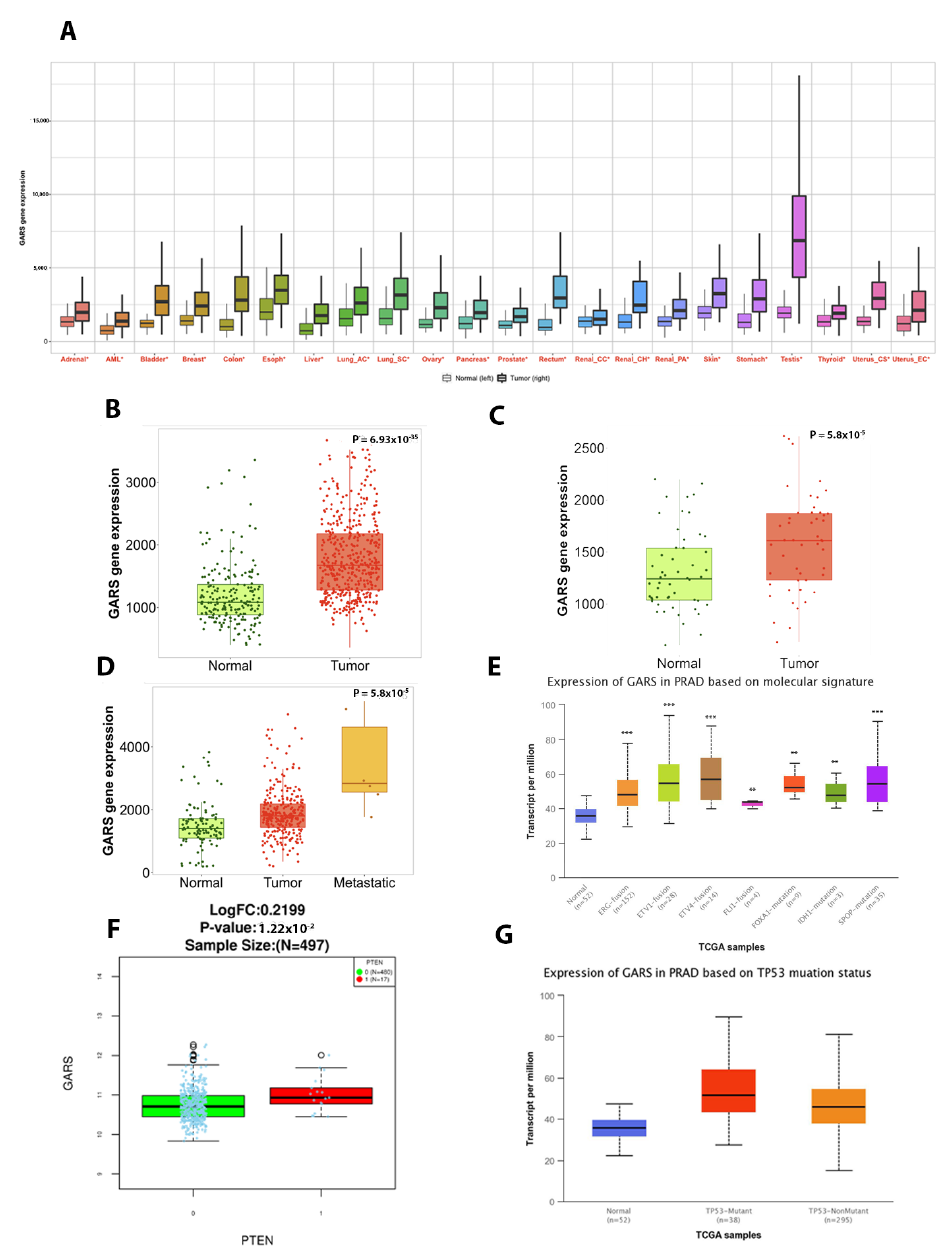
Figure 3. Gene expression analysis of GARS in tumors and normal tissues. ( A ) Boxplots represent the GARS mRNA gene expression in 22 types of cancer in Tumor (right) and normal (left). The Mann–Whitney U test was used, and significant difference is marked with red * ( p < 0.01). ( B – D ) Boxplots represent the GARS RNA-seq gene expression in ( B ) PCa tumor and normal tissue from non-cancerous patients, ( C ) Pca tumor and paired adjacent-normal tissue, ( D ) Pca tumor, normal tissue, and metastatic Pca. ( E ) Boxplots showing GARS association with common PCa mutations ( ERG , ETV1 , ETV4 , FLI1 , FOXA1 , IDH1 and SPOP ) (Asterisks indicate significant p value, * p value < 0.05, ** p value < 0.01, *** p value < 0.0001). ( F ) Boxplots representing GARS gene expression in relation to PTEN loss (0—wild type, 1—loss mutations). ( G ) Boxplot shows GARS gene expression in relation to TP53 mutations (red represents mutated gene and green is